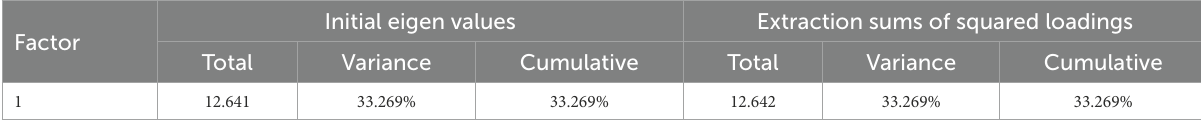
TABLE 5 Common method variance